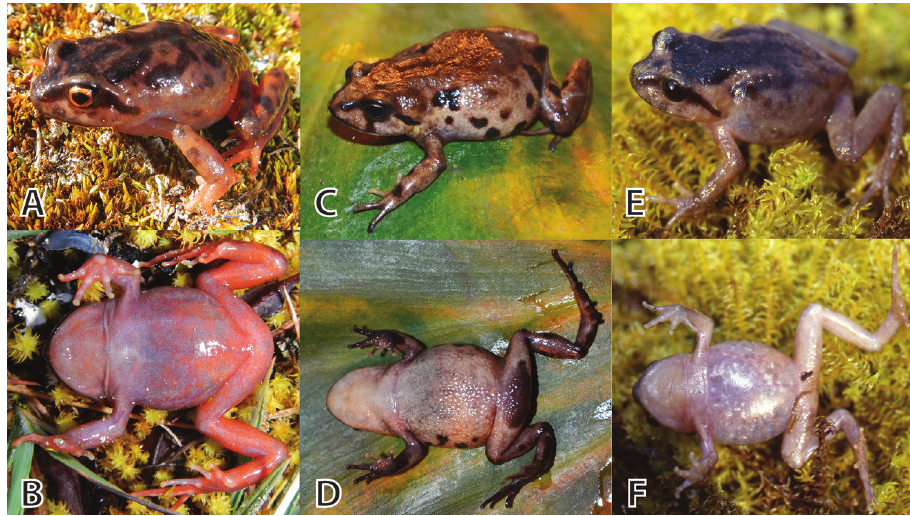
Figure 4. Phrynopus inti sp. n. ( A, B holotype, MUSM 31183, male, SVL 32.5 mm), P. juninensis ( C, D MUSM 33258, female, SVL 33.0 mm) , P. kauneorum ( E, F holotype, MUSM 20459, female, SVL 29.1 mm) in dorsolateral and ventral views. Photos by E. Lehr and R. von May ( C, D